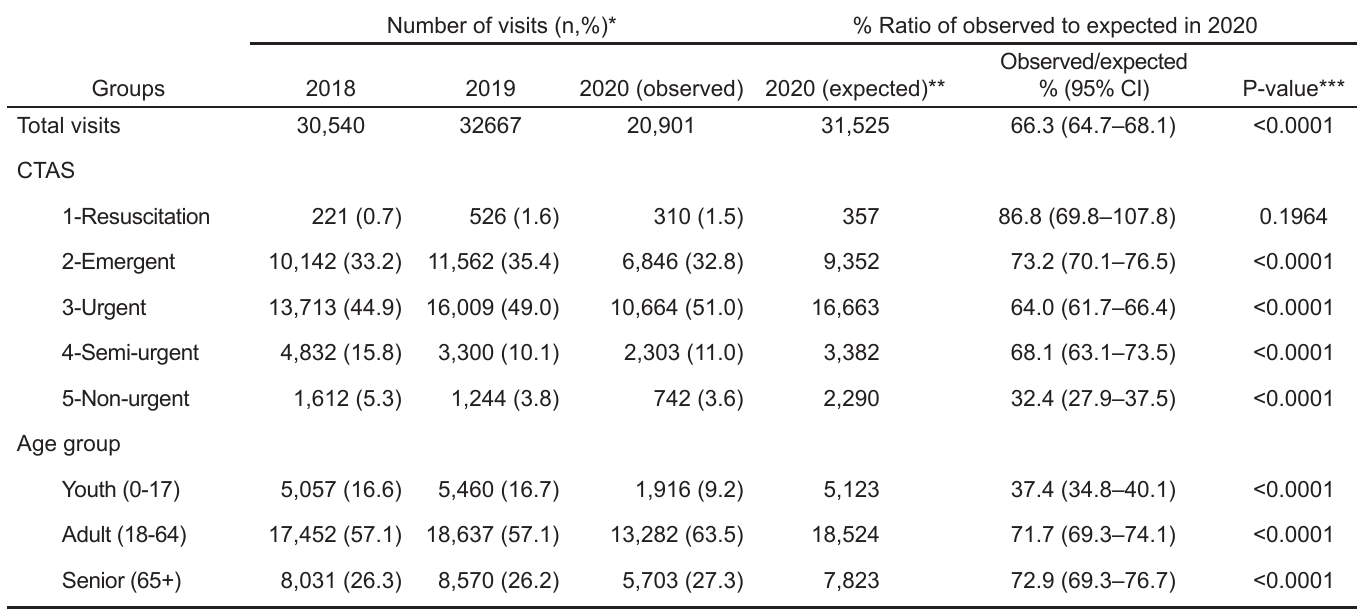
Number of visits